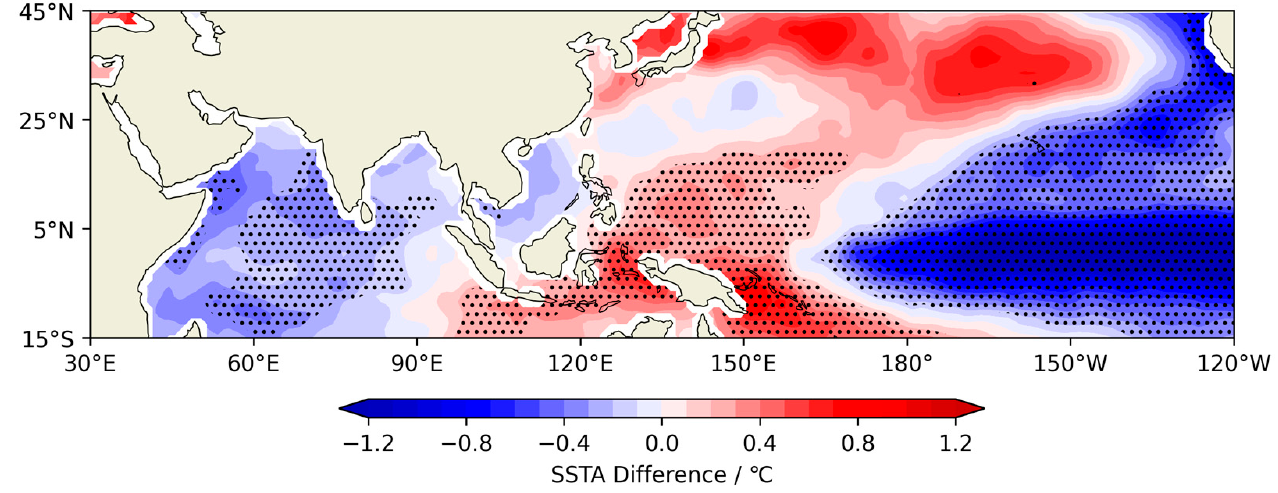
Figure 8. Distribution of SSTA differences (strong years minus weak years) in the tropical Indo-Pacific Ocean during TC season (May to December) in anomalous SCSSM years. Dots mark areas that are statistically significant at the 90% confidence level.